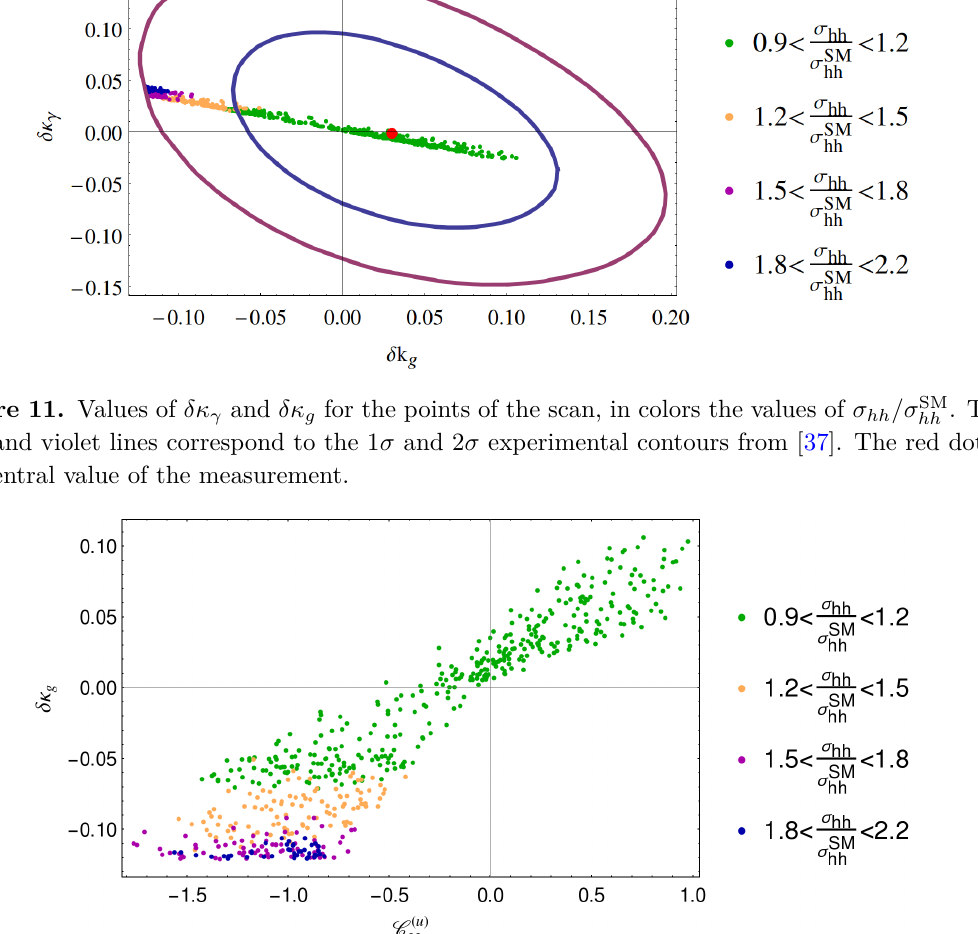
Figure 12. δκ g as a function of C ( u )